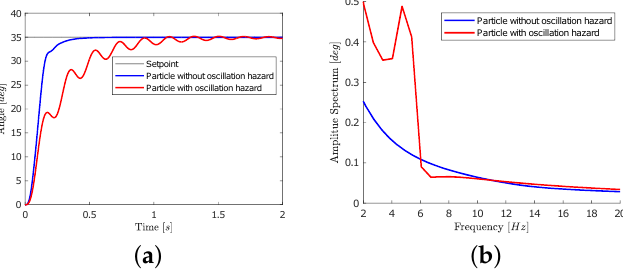
Figure 7. ( a ) Roll axis step response simulation for oscillation hazard determination . ( b ) FFT of roll axis step response simulation.